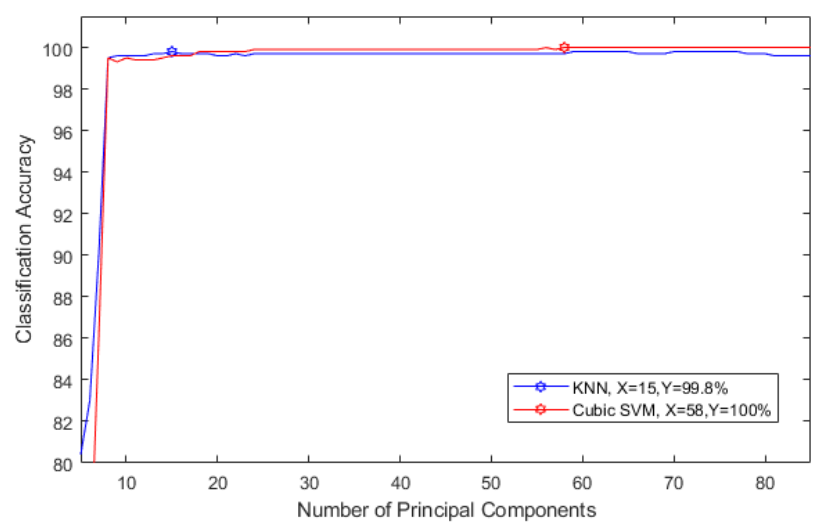
Figure 13. Selecting the optimal number of principle components for evaluating stress levels. Figure 12. Selecting the optimal number of principle components for detecting stress .